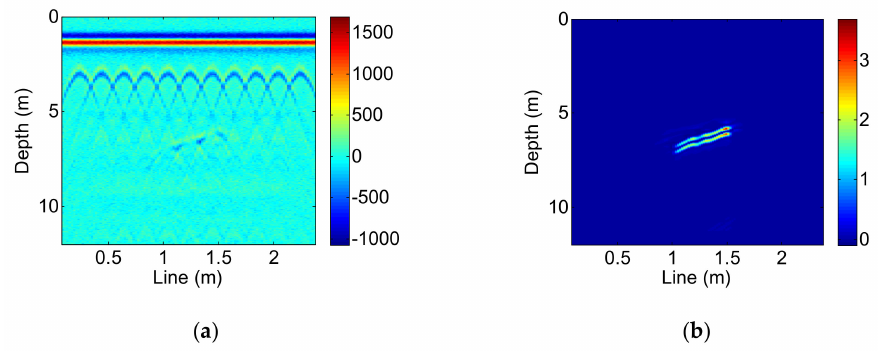
Figure 17. Disease detection results: ( a ) before detection, and ( b ) detection